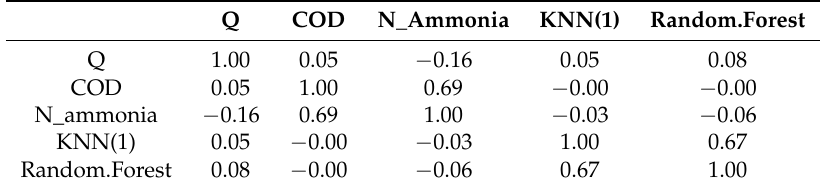
Table 6. Final correlation between measures and predictions of the best two